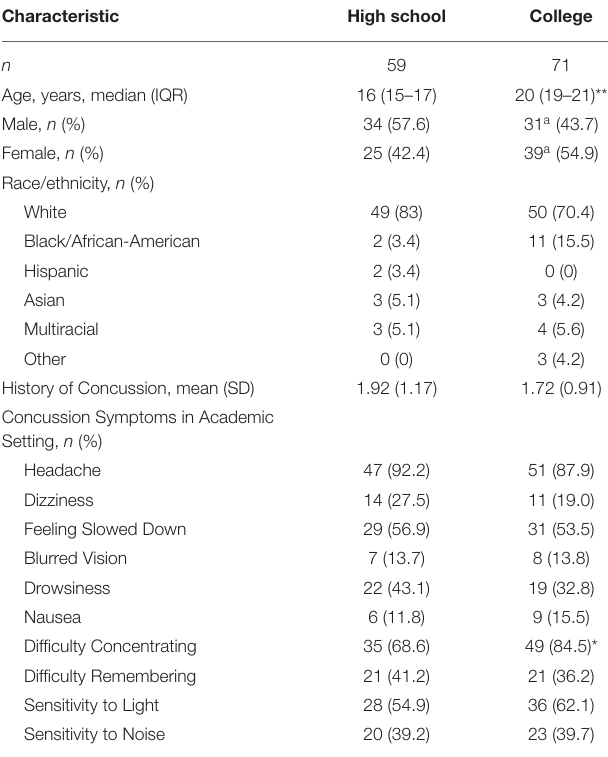
TABLE 1 | Demographic and concussion symptoms experienced in academic